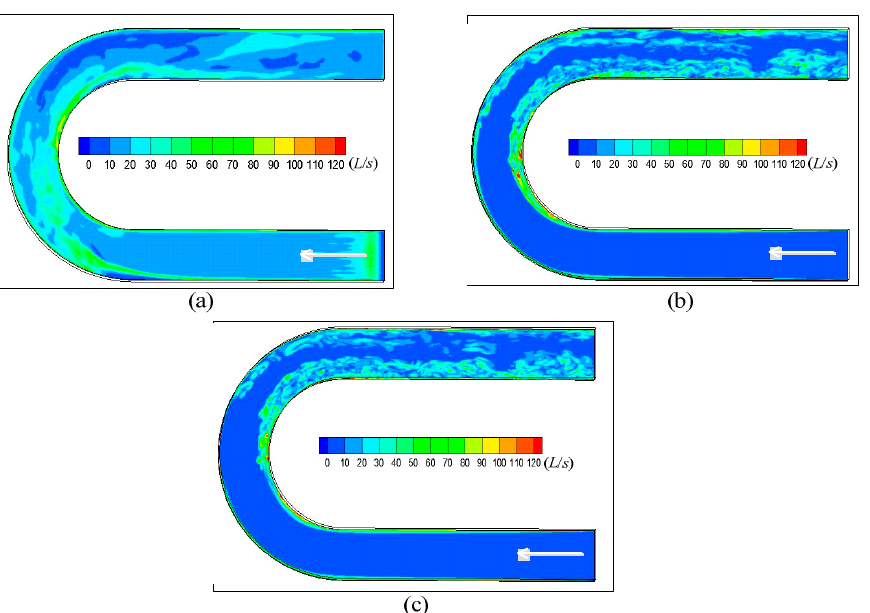
Figure 15. Vorticity distribution at different water depths: ( a ) z / H = 0.9; ( b ) z / H = 0.5; ( c ) z / H = 0.2.